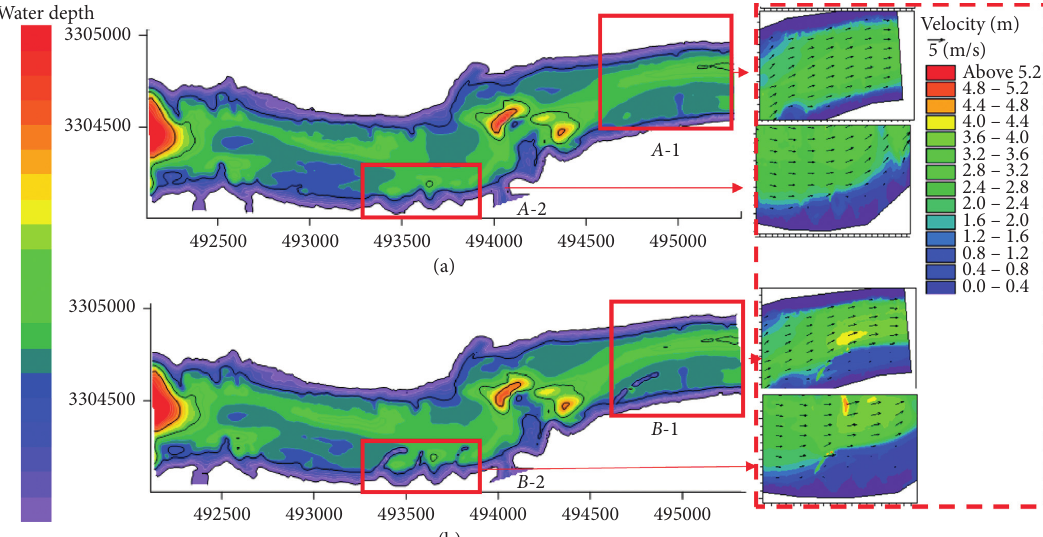
Figure 4: Comparison of the water depth and the local velocity distribution. (a) Before the regulation. (b) After the regulation.